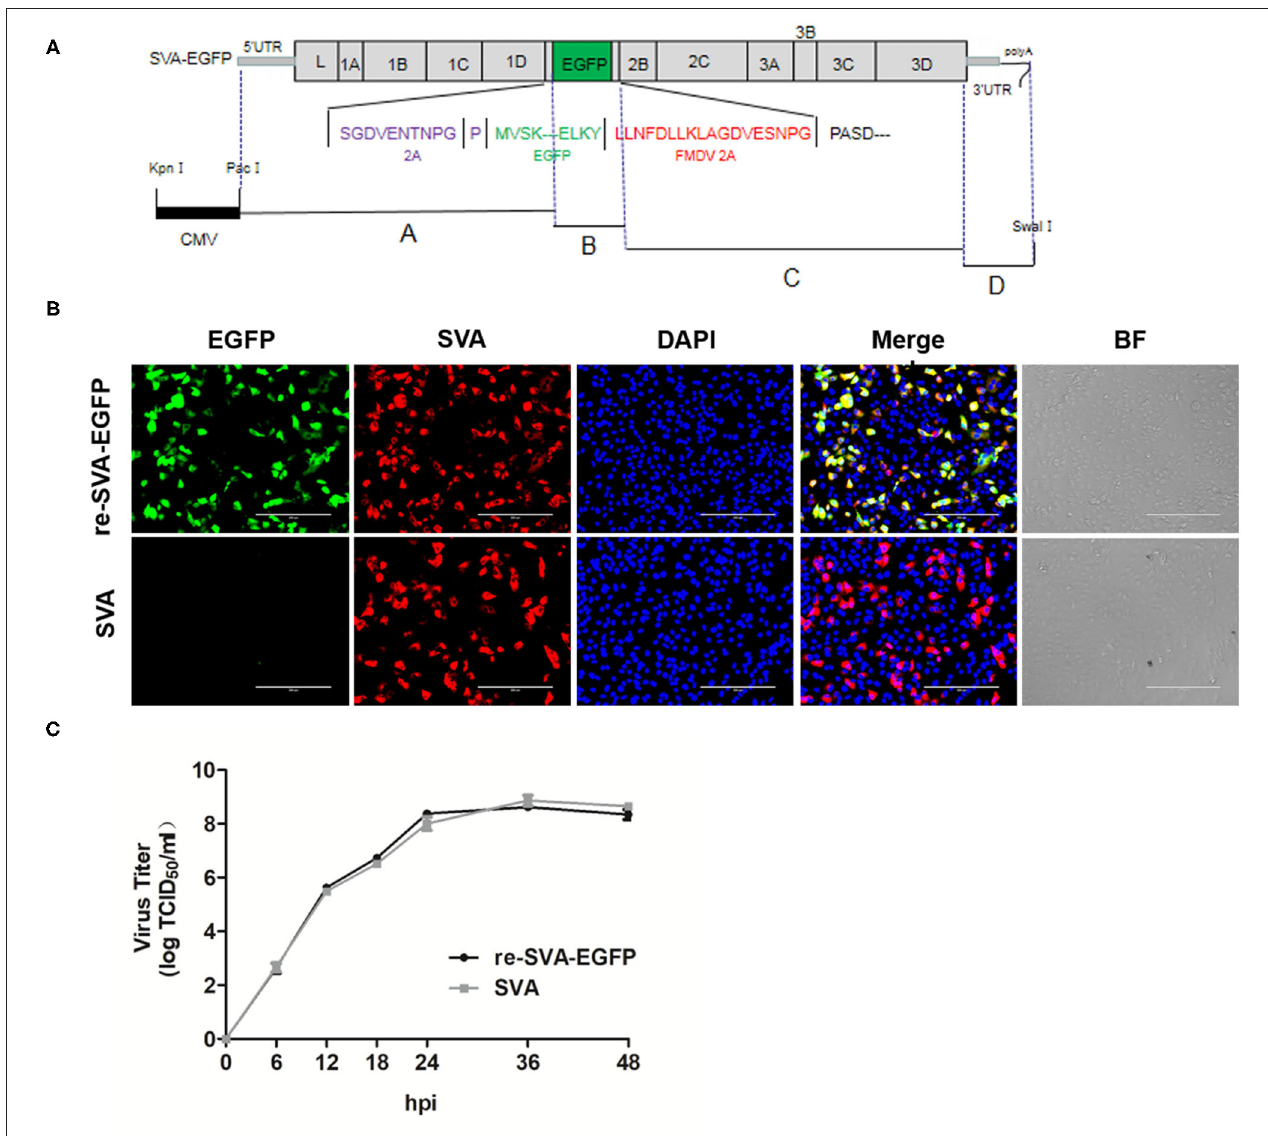
FIGURE 1 | Schematic diagram of the full-length SVA genome and Generation of re-SVA-EGFP infectious clone. (A) The construction strategy of SVA clone. Four separate fragments, A to D, were assembled into the pBluescript II SK ( + ) vector using homologous recombination and the unique restriction enzyme sites. A hammerhead ribozyme and a HDV ribozyme was located at the 5 ’and 3’ ends of the SVA genome, respectively. The full-length genome is under the control of a CMV promoter. (B) Immunofluorescent assay for detecting SVA infection and EGFP expression. The SVA infected was labeled in red, EGFP was in green, and DAPI stained cell nucleus in blue. (C) One-step growth curve of re-SVA-EGFP infectious